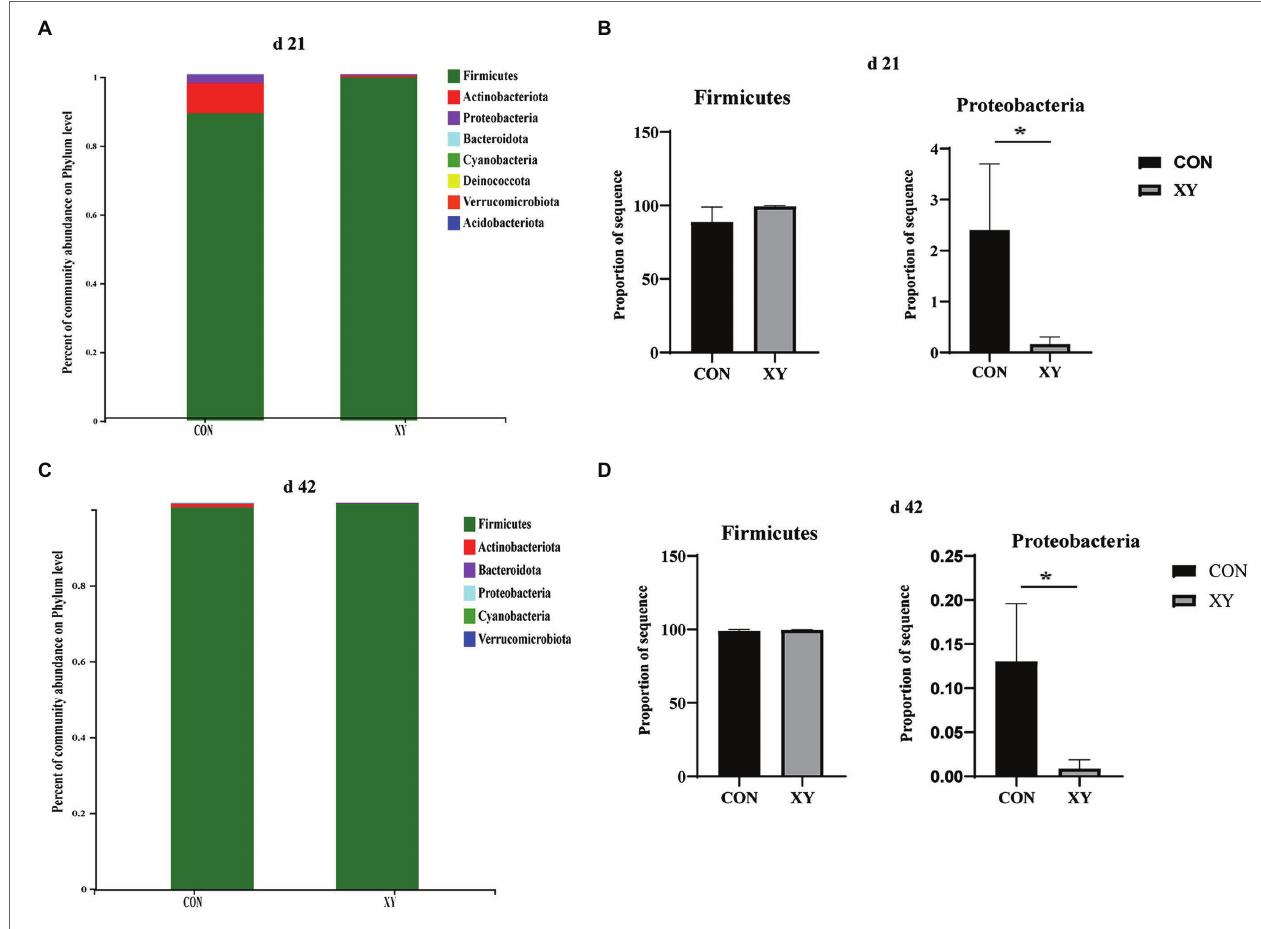
FIGURE 3 | Effects of AT-xynA on ileal microbiota composition at the phylum level. (A,C) Ileal microbiota composition at the phylum level in broilers; (B,D) alterations of the abundance of bacterial phyla found in the ileum of broilers. CON is AT-xynA un-supplemented group; XY is 4,000 U/kg AT-xynA supplemented group. The “*” indicates a significant difference between the two treatments ( p <